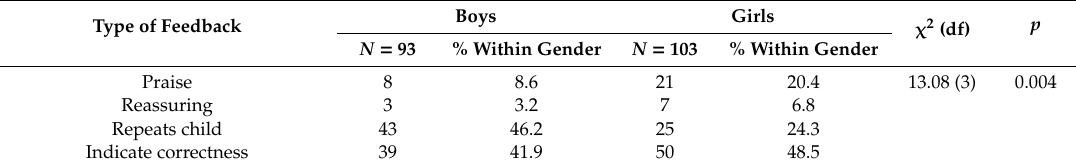
Table 5. Chi-square test of independence of gender and type of feedback from teacher.